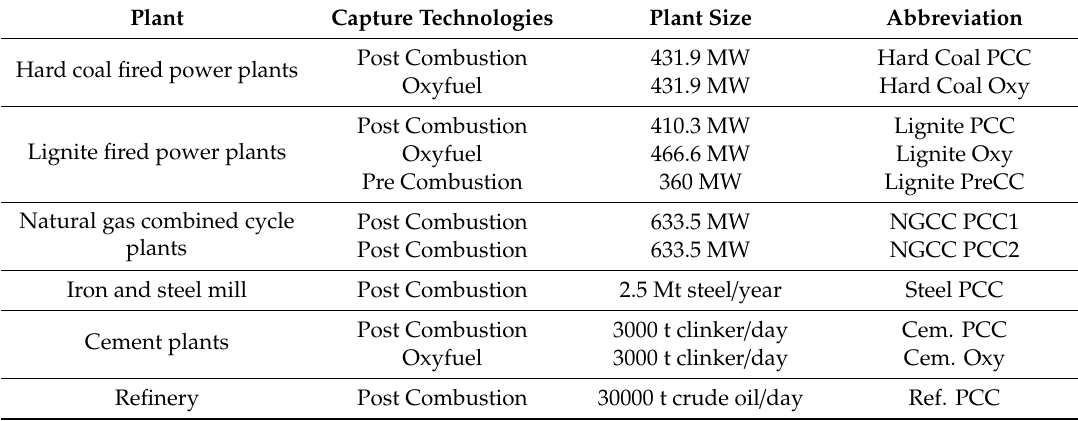
Table 1. Considered power plants and industrial plants with respective CO 2 capture technologies. Plant Capture Technologies Plant Size Abbreviation Post Combustion 431.9 MW Hard Coal Hard coal fired power plants